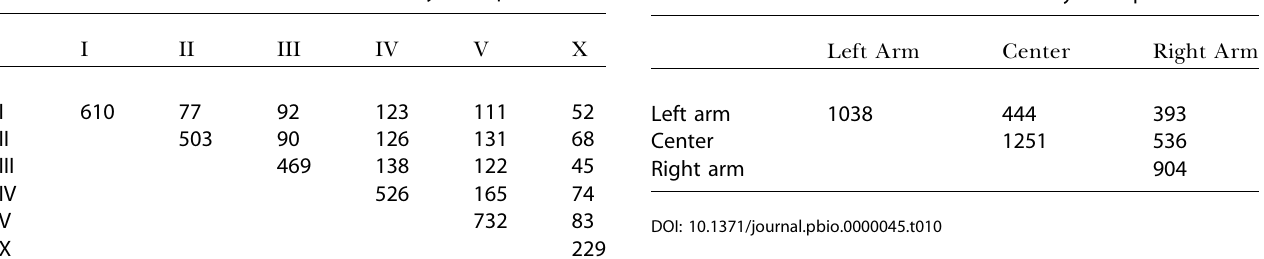
Table 9. Chromosomal Partners at Colinearity Breakpoints Table 10. Chromosomal Arms at Colinearity